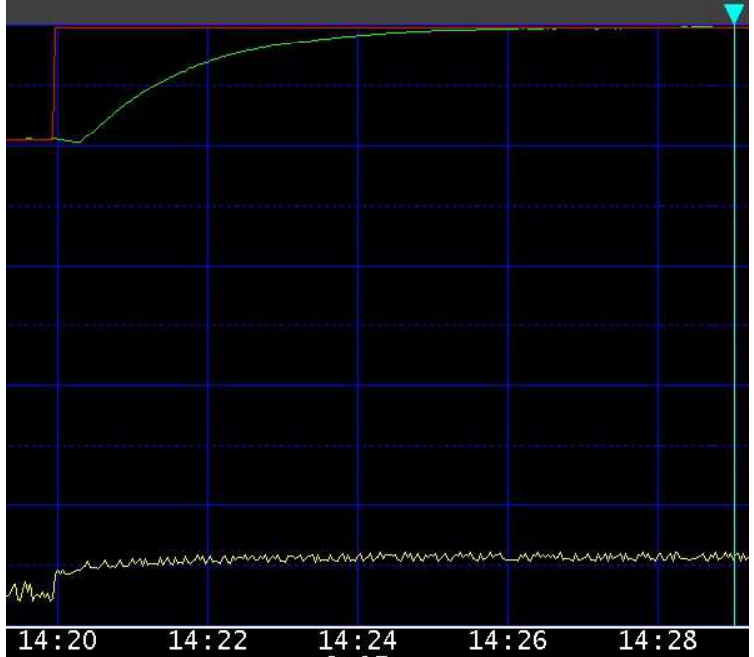
Figure 6. Initial set-point step response in the flow control loop. Top: process variable. Bottom: control variable.